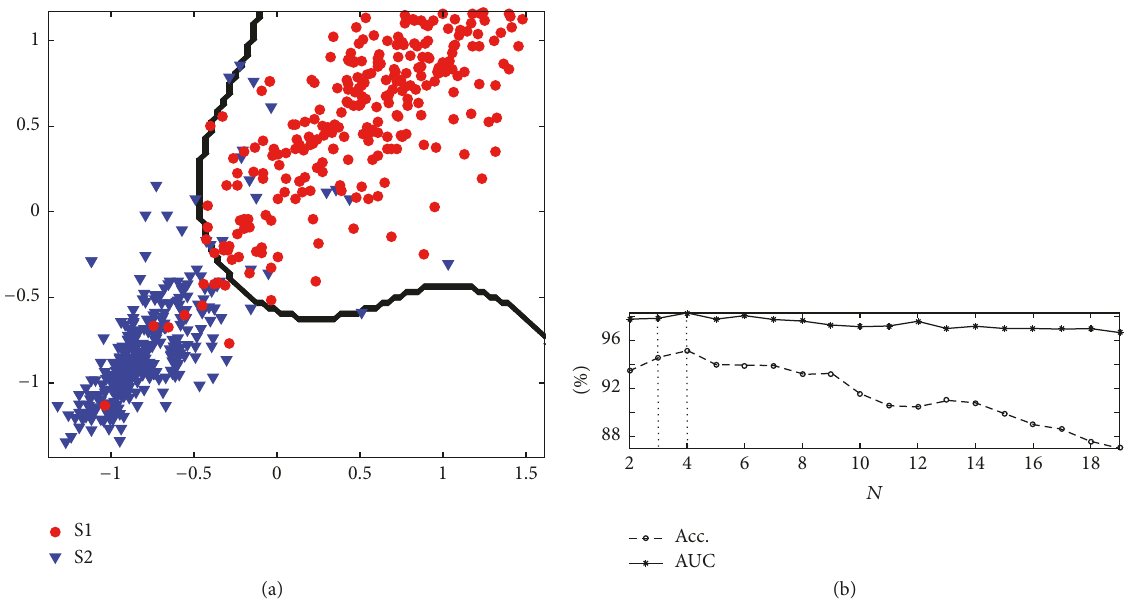
Figure 5: (a) Decision boundary for the two proposed shape context methods, 𝑁 = 2 . (b) The calculated validation accuracy and AUC values for different number of descriptors.